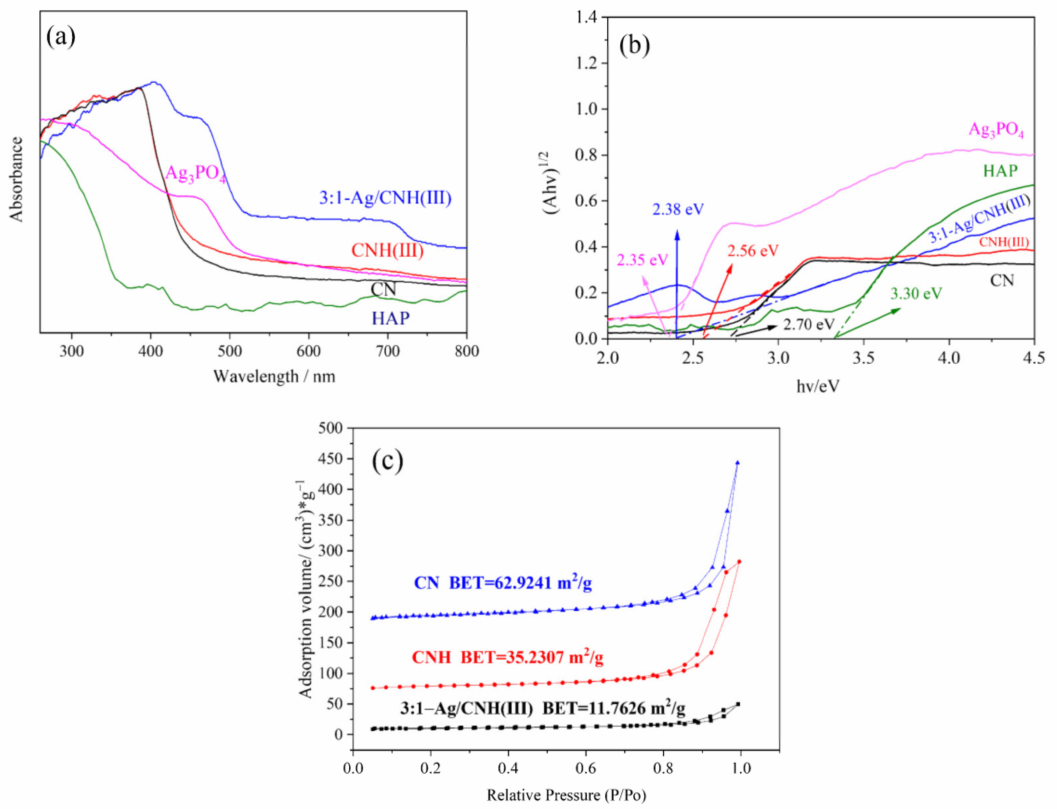
Figure 5. ( a ) UV–VIS absorption spectra, ( b ) Tauc plots, and ( c ) N 2 adsorption-desorption isotherms of different